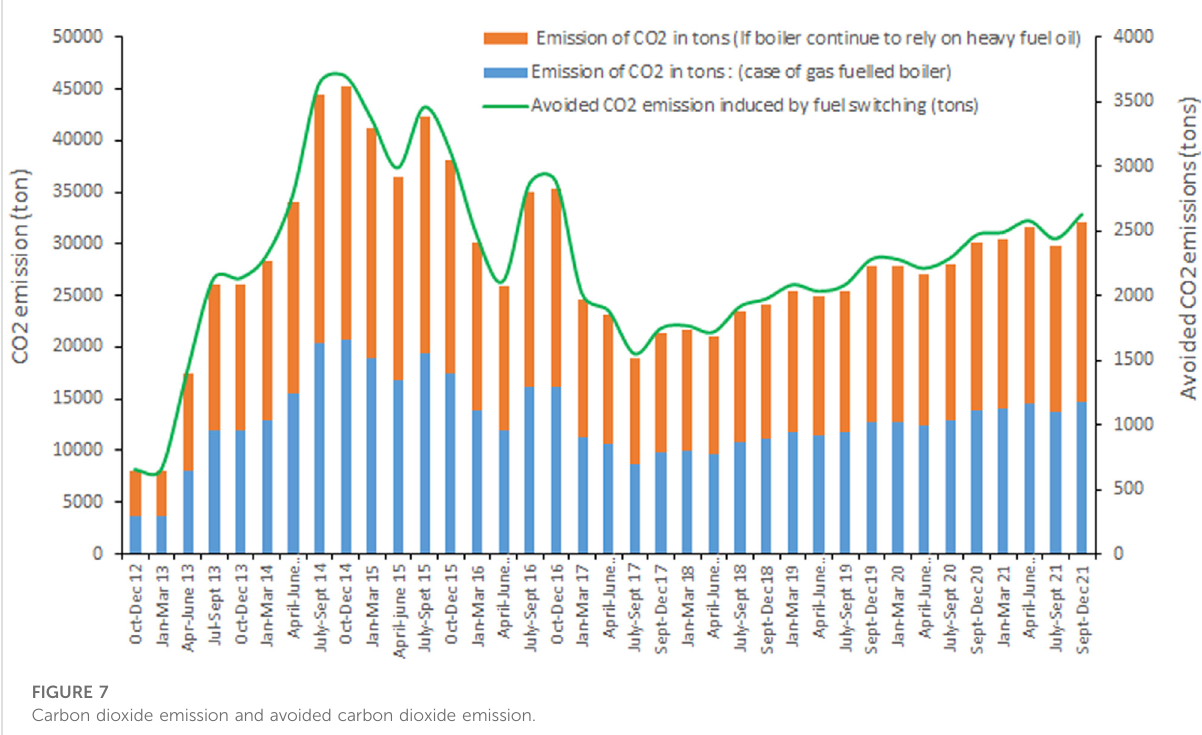
FIGURE 7 Carbon dioxide emission and avoided carbon dioxide emission.